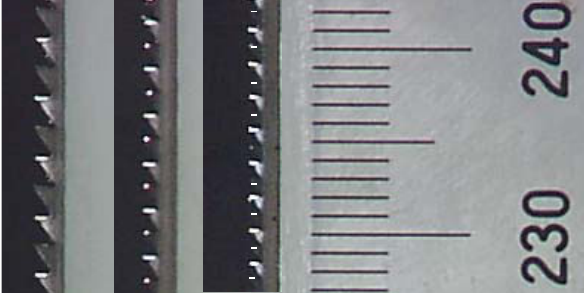
Fig. 3 Jigsaw Blades Attached to the Leading Edge, From the Left, 16, 20, 28 Teeth/ Inch Blades.